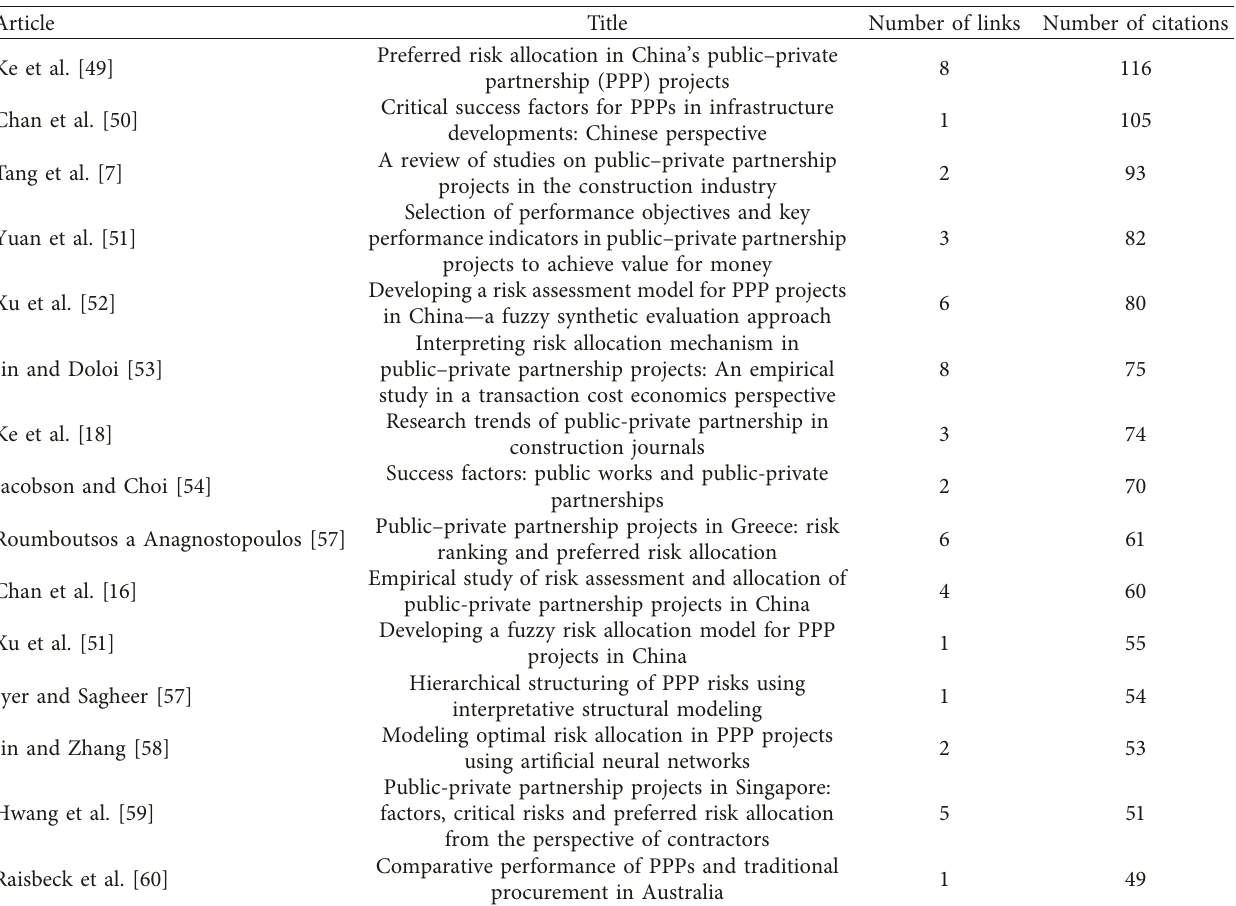
Table 5: List of PPP articles with high citations.